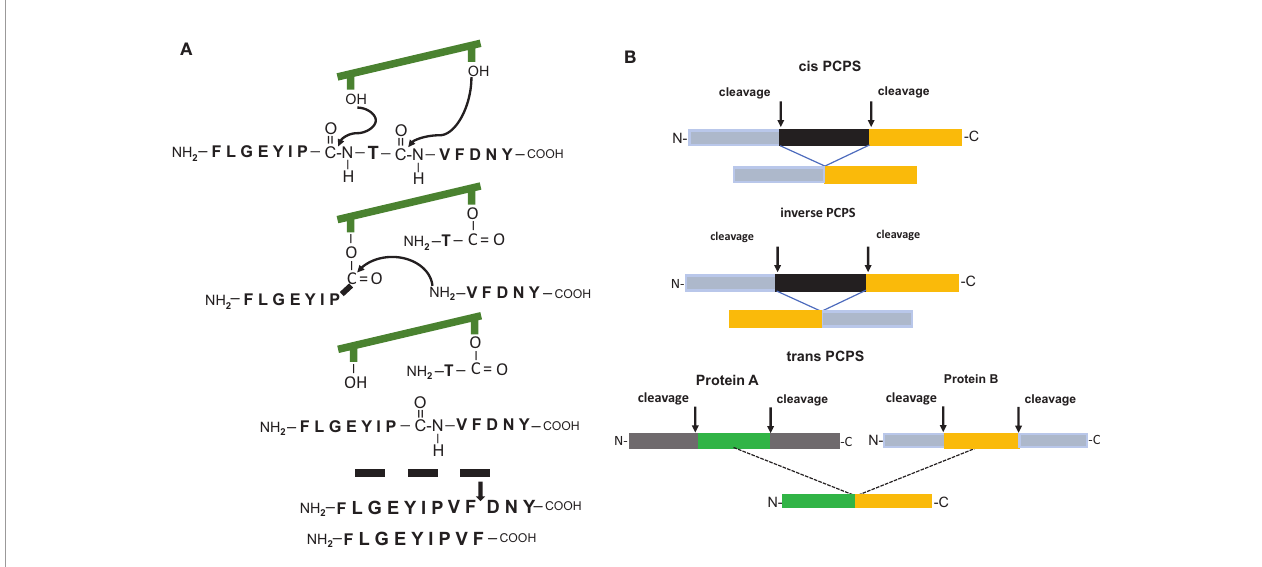
FIGURE 1 | (A) Model of the peptide splicing reaction for the putative RAC2 P29L neosplicetope, adapted from Vigneron et al. (11). The spliced peptide requires an additional proteasomal cleavage for 9mer generation. (B) Proteasome catalyzed peptide splicing in cis, inverse and in